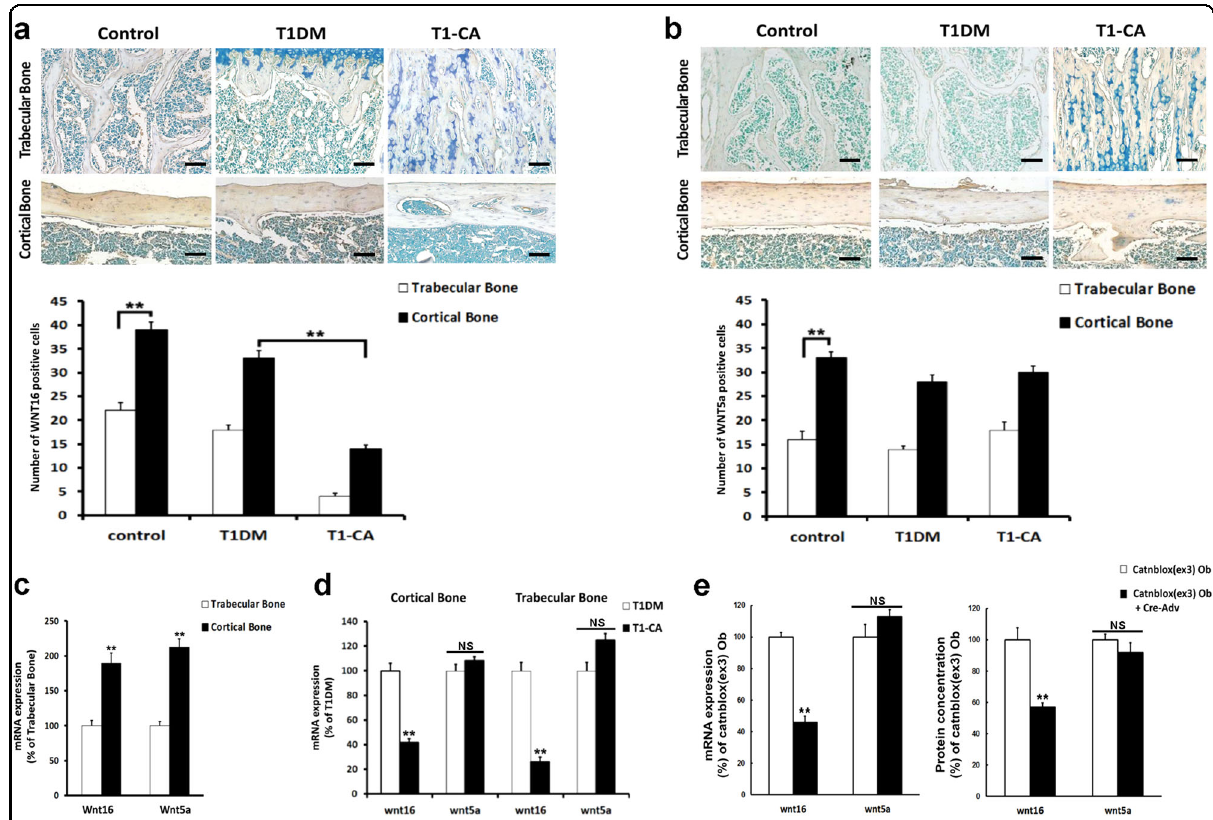
Fig. 6 Downregulated expression of WNT16 was responsible for the unexpected increased bone resorption in cortical bone of T1-CA mice. a WNT16 and b WNT5a protein expressions were detected by immunohistochemistry in longitudinal sections of femoral trabecular and cortical bone. The quantitative results are shown. n = 9. Scale bars, 50 μ m. c mRNA expression levels of WNT16 and WNT5a in trabecular and cortical bone of control mice. n = 8. d mRNA expression levels of WNT16 and WNT5a in trabecular bone and cortical bone in T1DM and T1-CA mice. n = 8. e mRNA expression levels and protein concentrations of WNT16 and WNT5a in primary osteoblasts from Catnblox(ex3) mice treated with high glucose plus Cre adenovirus or vehicle. n = 8. Ob osteoblast. Data are expressed as the mean ± SD. ** P < 0.01 versus trabecular bone ( a – c ), T1DM group ( d ) or Catnblox(ex3) osteoblasts ( e ) by an unpaired t -test. NS not signi fi cant, P >